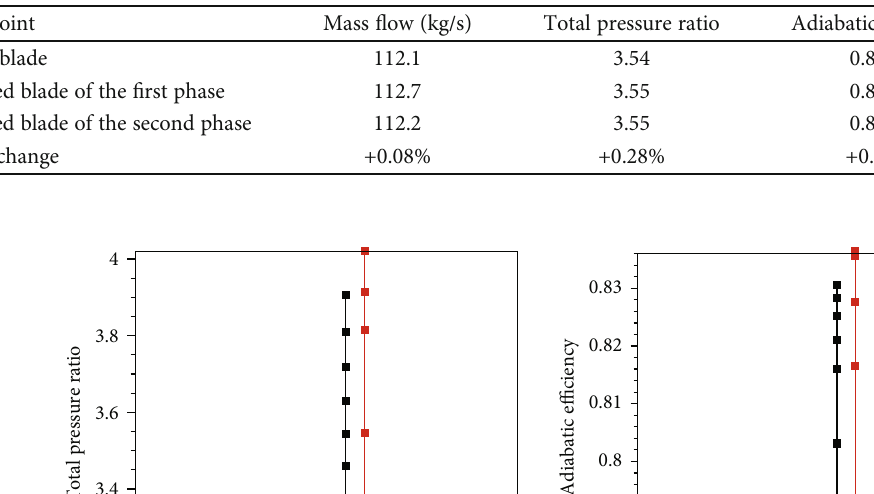
Table 5: Performance comparison before and after optimization at the design point in the two phases.